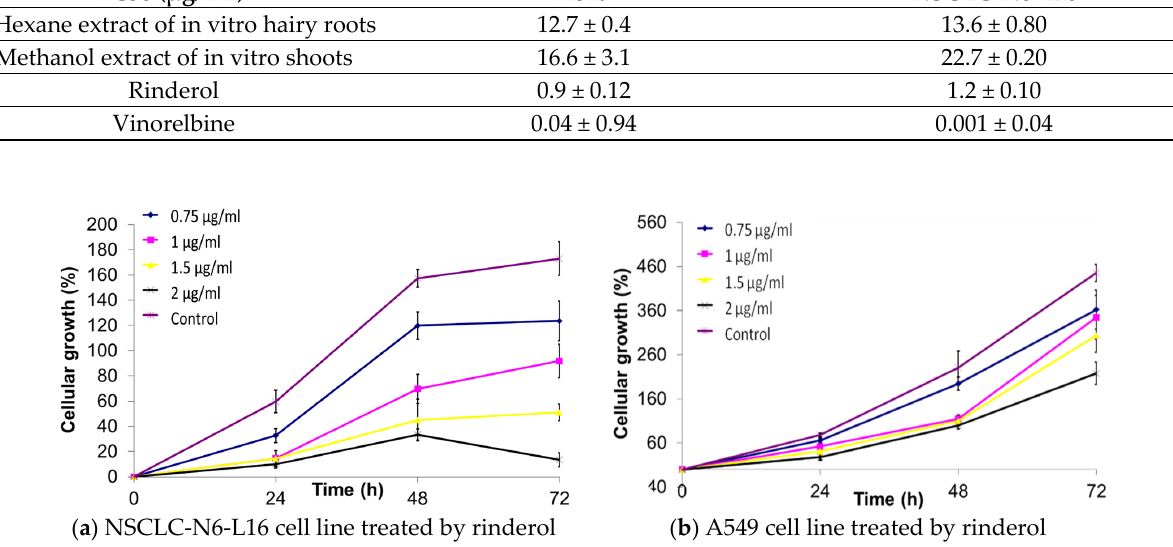
Figure 3. Result of continuous growth kinetics of NSCLC ‐ N6 ‐ L16 ( a ) and the line A549 ( b ) cell lines after treatment with different concentrations of rinderol in a period of 72